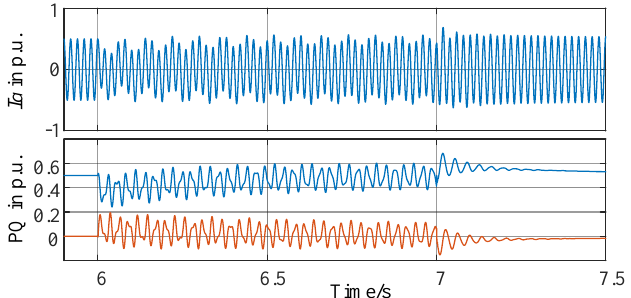
Figure 12. Simulation waveforms when disable/enable the cascaded control loop in the VSG controlled converter with the series-compensated grid: (top) system current in phase-a; and (bottom) the blue line is active power and the orange line is reactive power.